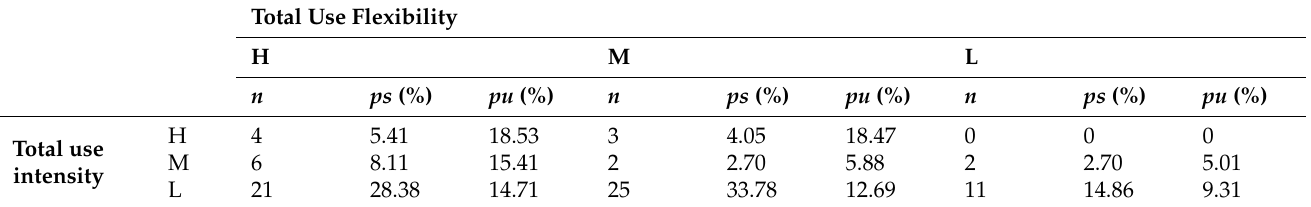
Table 7. Use mode distribution of pocket parks.